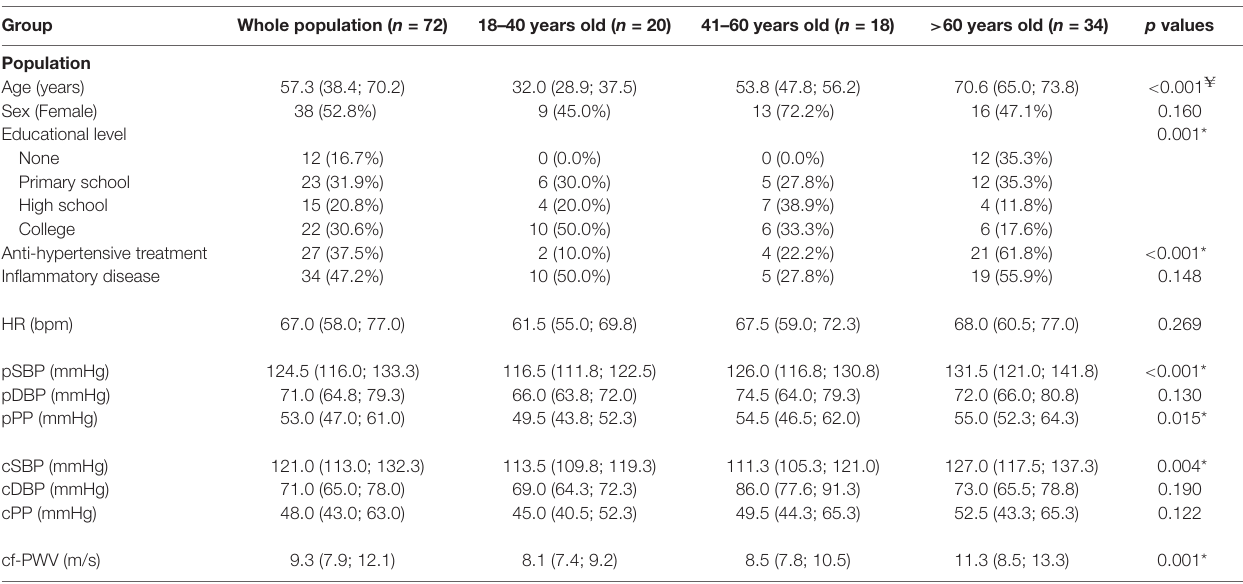
TABLE 1 | Population